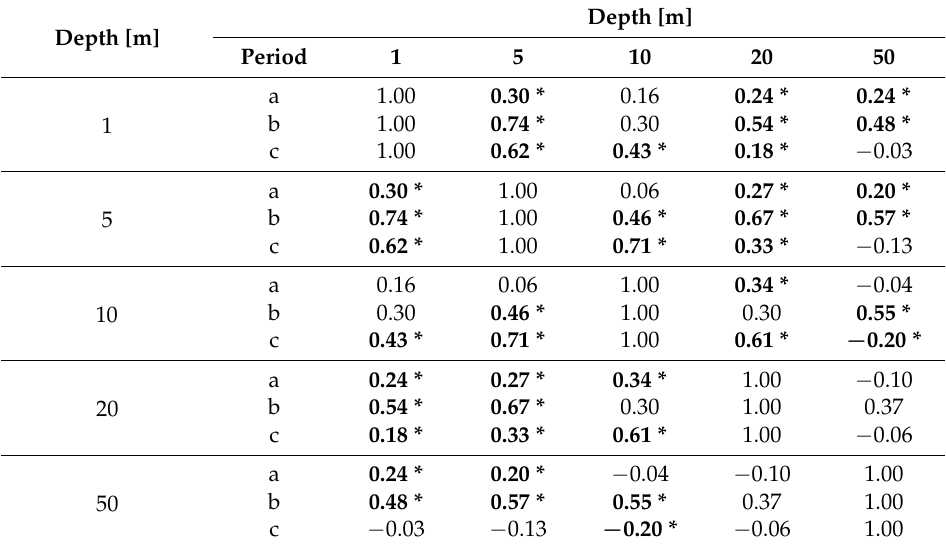
c − 0.03 − 0.13 1.00 * statistically significant correlation coefficients ( p <